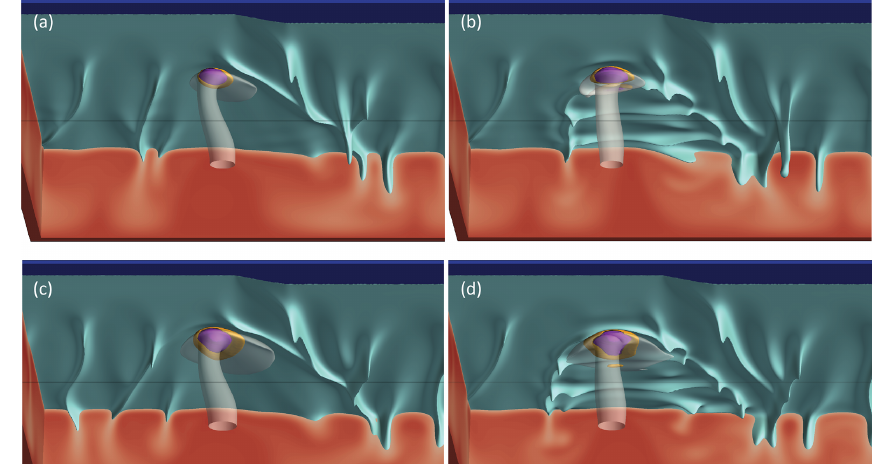
Figure 7. Steady-state snapshots of representative cases with variable D plume . (a, c) Cases with D plume = 200km. (b, d) Cases with D plume = 400km. Panels (a) and (b) : models with a relatively weak plume with (cid:49)T plume = 150 ◦ C and B plume = 100kgs − 1 are shown. Panels (c) and (d) : models with a relatively strong plume with (cid:49)T plume = 200 ◦ C and B plume = 200kgs − 1 are shown. For reference to colors of surfaces and cross sections, see Fig. 3 caption and legend. The 3D perspective is the same as in Fig.